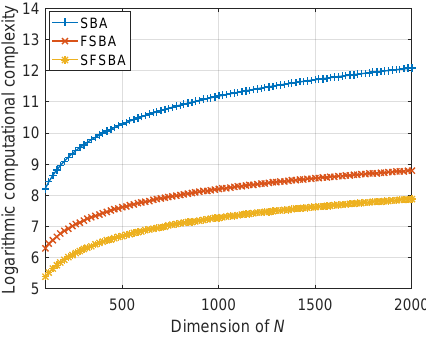
Figure 2. Logarithmic computational complexity of SBA, FSBA and SFSBA.